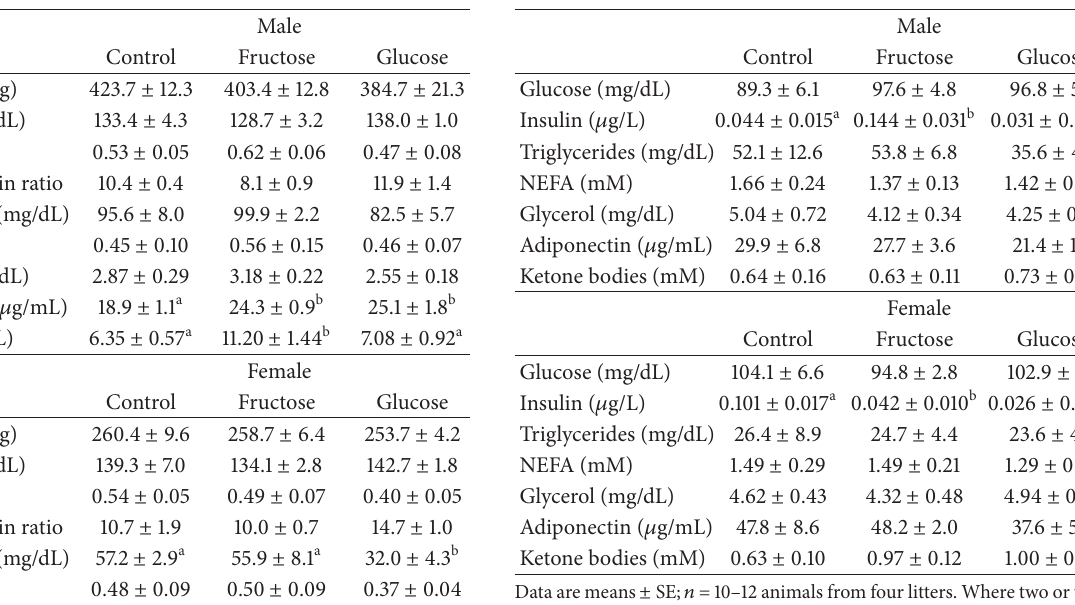
Table1:Bodyweightandplasmaanalytesinfed90-day-oldprogeny from fructose- or glucose-supplemented mothers.